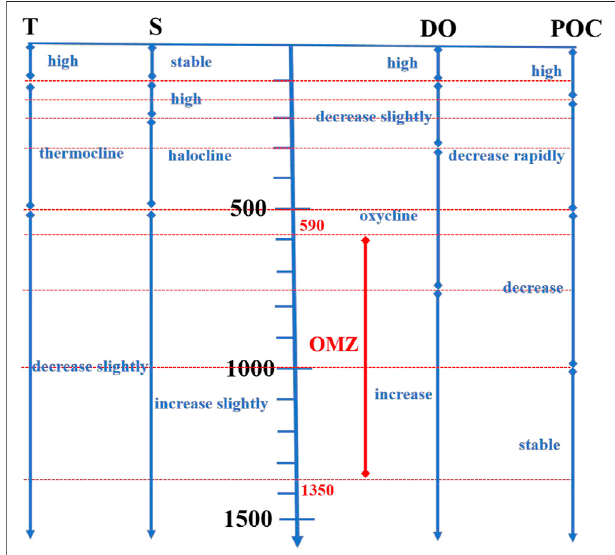
FIGURE 6 | Relationship among OMZ, T, S, DO, and POC. The red line represented OMZ. This fi gure showed changes of these parameters with the increase inwater depth. Theseparameters wereall stable inthe watercolumn of 0 – 100 m due to the seawater mixing. Meanwhile, these parameters were also stable in the water column deeper than 1,000 m. OMZ was exactly located below the thermocline and halocline, and the DO in the OMZ fi rst decreased and then increased. The decomposition rate of POC in the OMZ was signi fi cantly lower than that in the upper